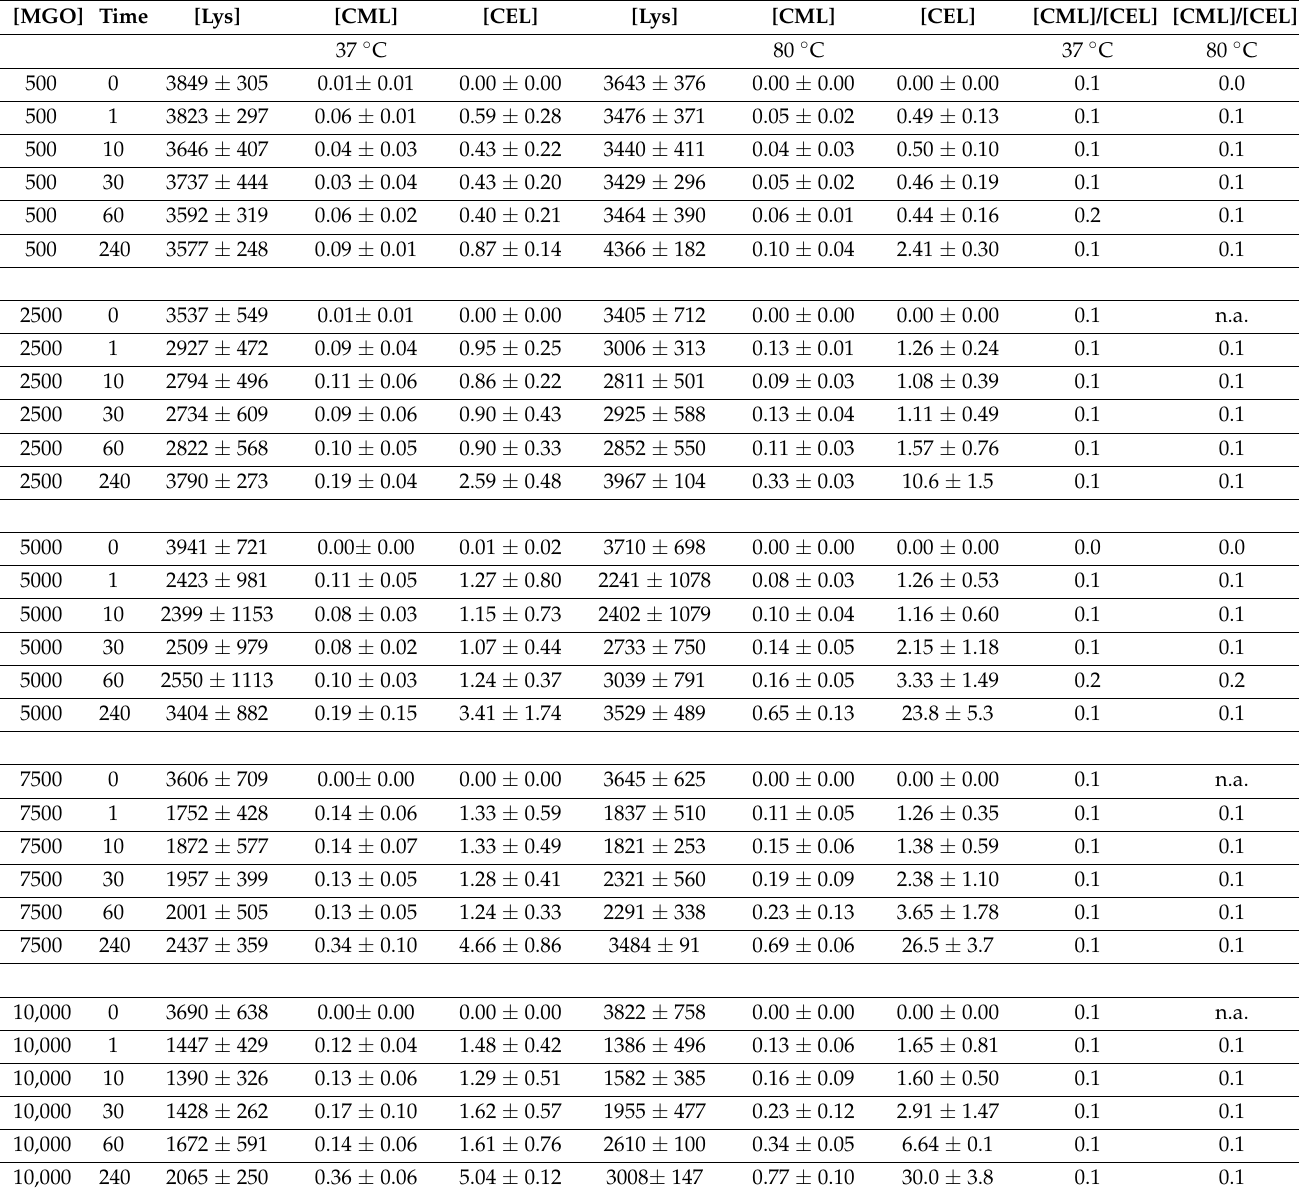
Table 5. Concentration (mean ± SD; µ M) of remaining Lys and formed CML and CEL from the reaction of Lys and MGO at initial concentrations of 5000 µ M and 500–10,000 µ M, respectively, at 37 ◦ C and at 80 ◦ C for the indicated times (min) in 100 mM phosphate buffer (pH 7.4), and molar ratios of CML and CEL. n.a., not